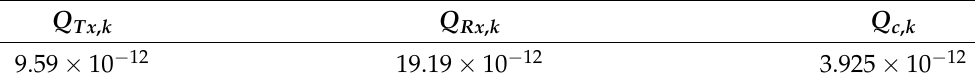
and R T (using log scale on x - and y -axis). C , k C , k + 1 associated with the system. C , k